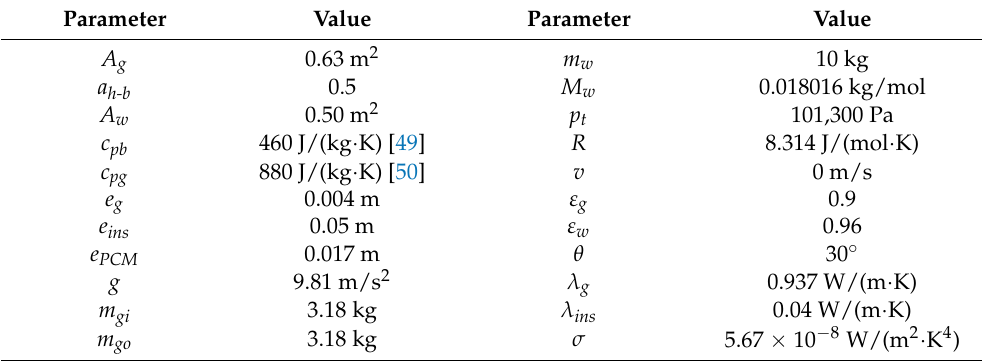
Table 3. Input parameters for the mathematical modeling—independent of the mass of PCM.